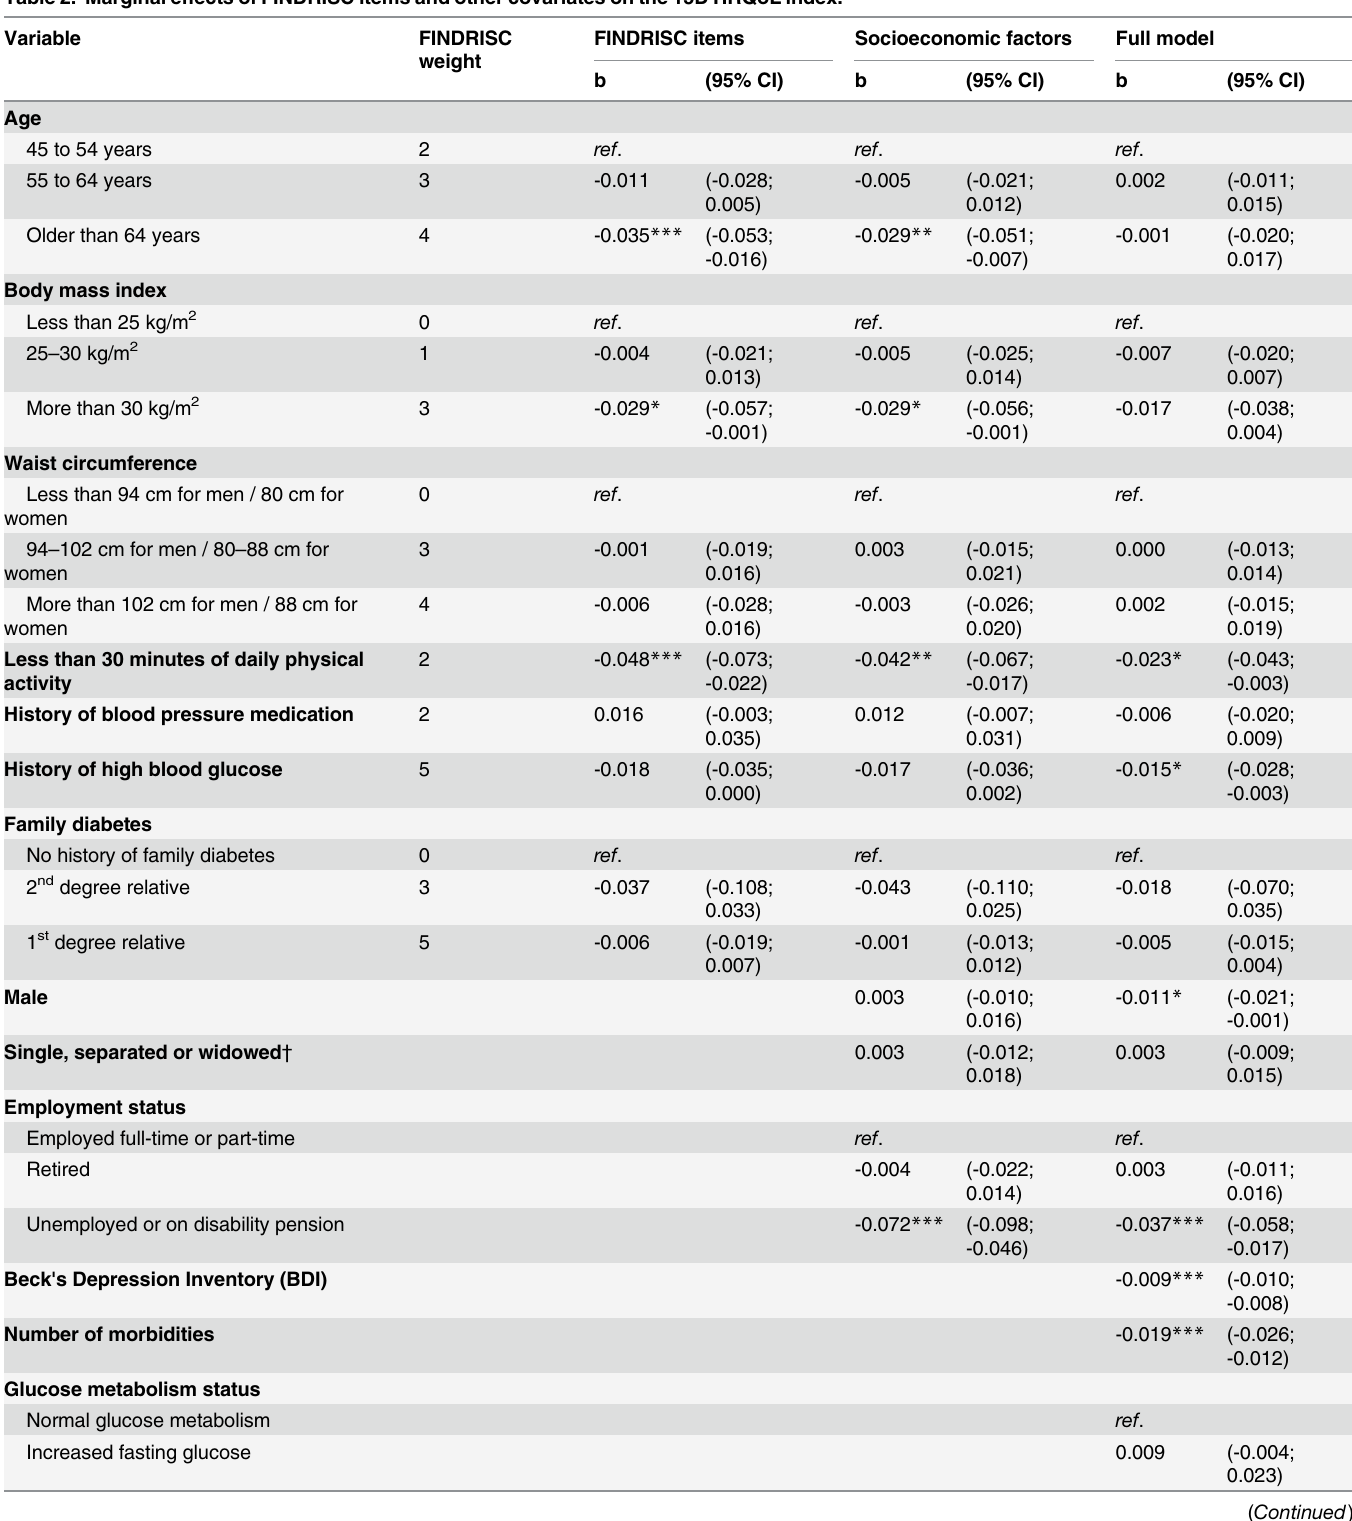
Table 2. Marginal effects of FINDRISC items and other covariates on the 15D HRQoL